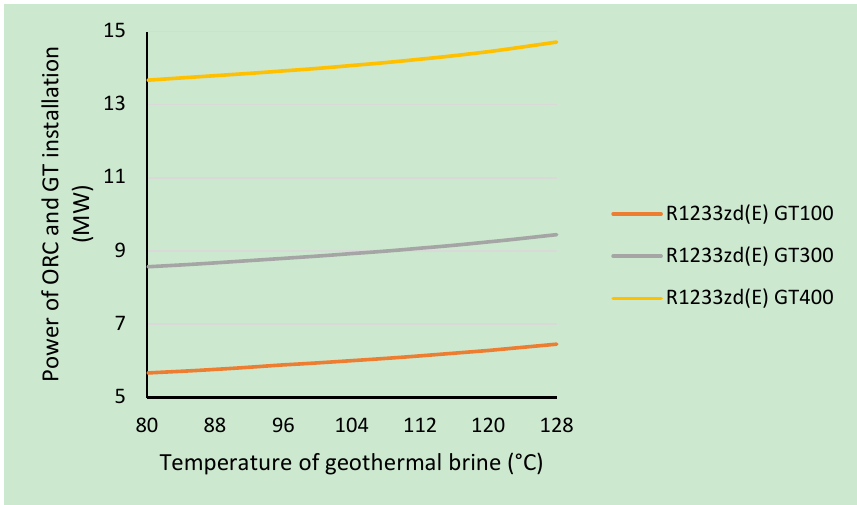
Figure 11. The power of modified ORC installation assisted by gas turbine as a function of the geothermal brine temperature with R1233zd(E) as a working fluid for different gas turbine types.